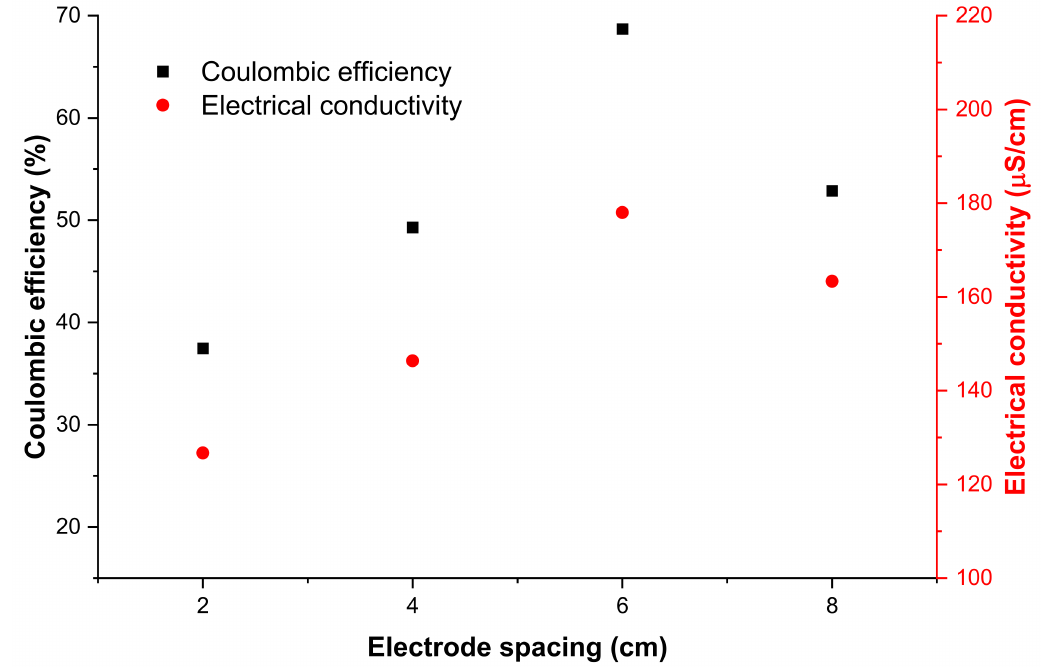
Figure 7. Coulombic efficiency and electrical conductivity as a function of electrode spacing.